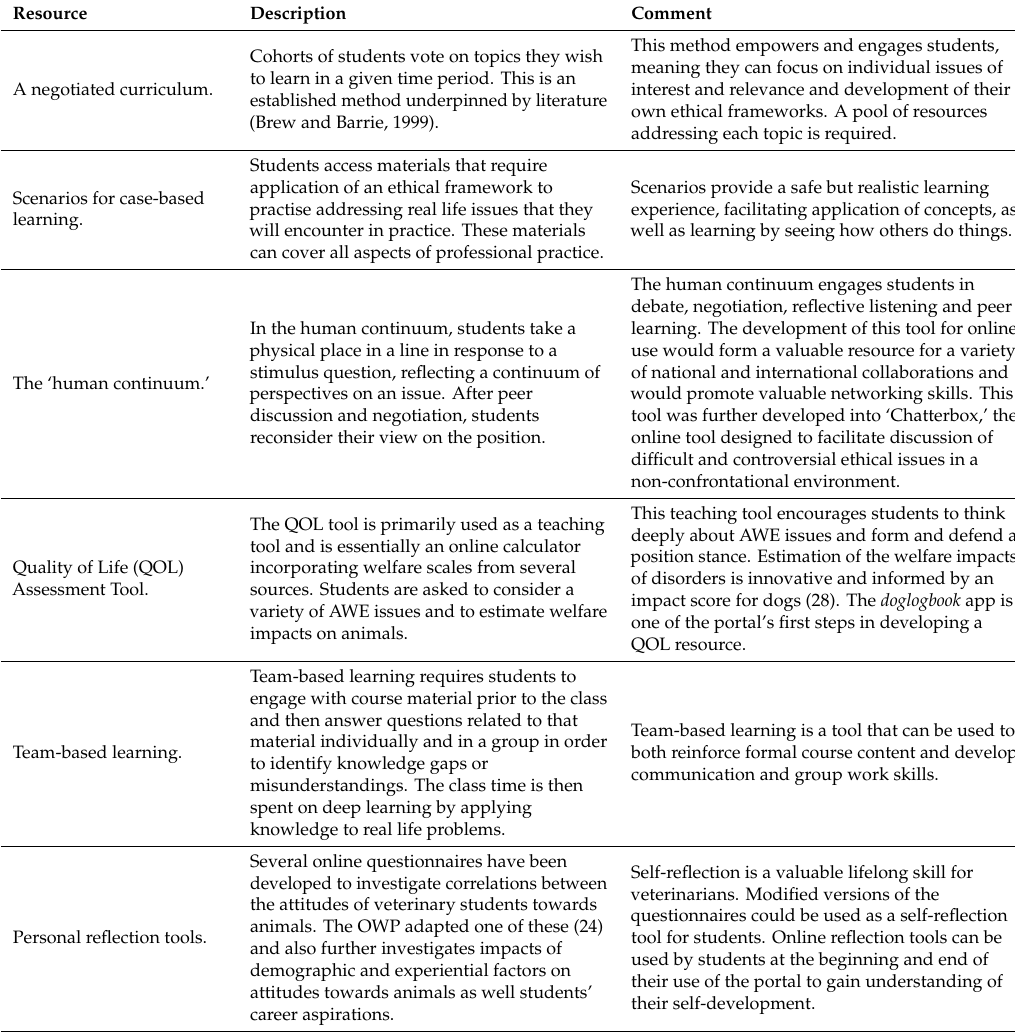
Table 1. Online resources considered by the panel for use in the One Welfare learning and teaching portal (OWP) at the 2014 University of Sydney